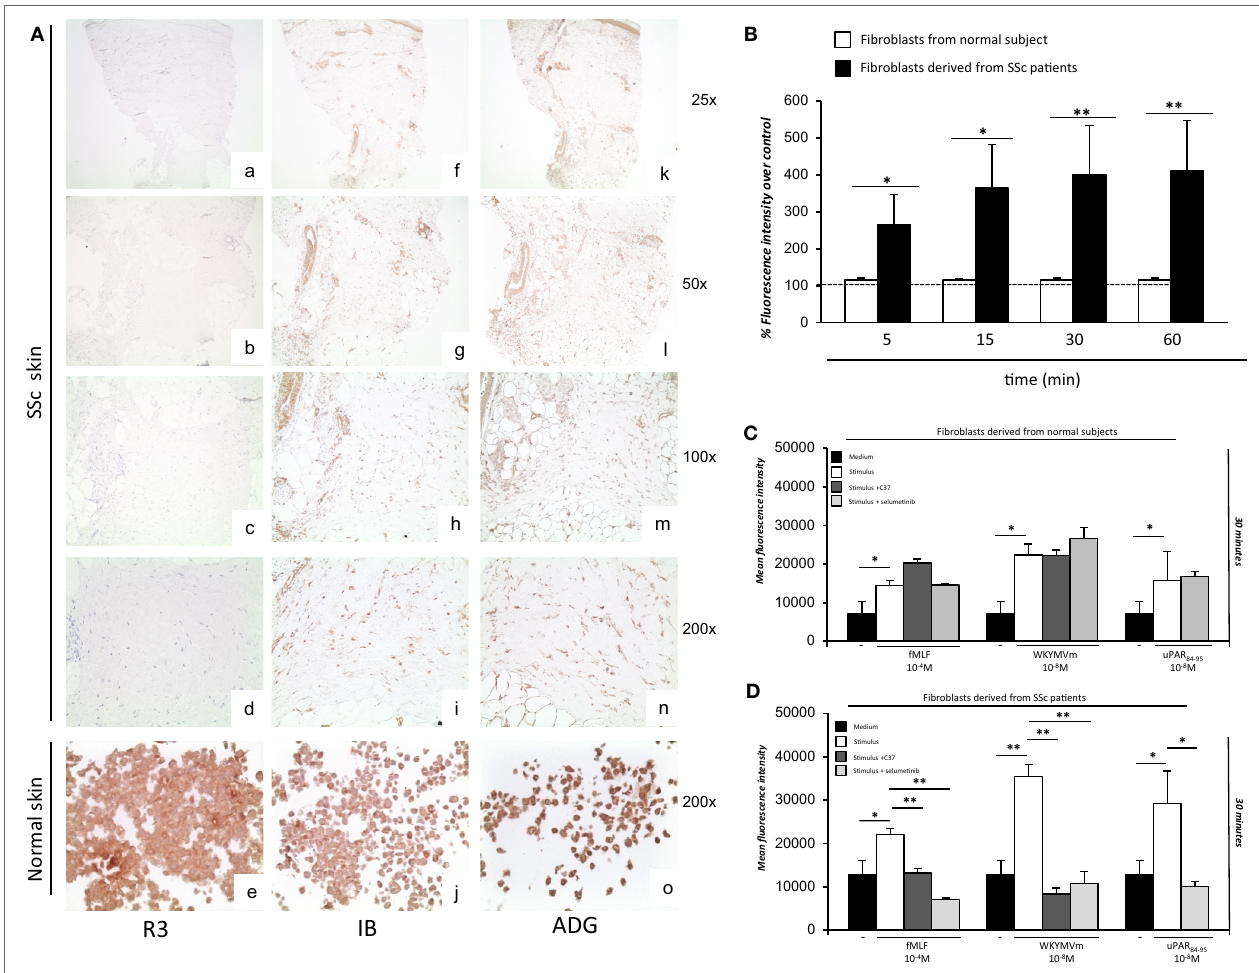
FigUre 7 | Ex vivo expression of uPAR forms and analysis of the effects of C37 and selumetinib on FPRs-mediated reactive oxygen species (ROS) production in fibroblasts derived from normal subjects and systemic sclerosis (SSc) patients. (a) (a–d) staining for R3 in localized scleroderma: fibroblasts, lymphocytes, and endothelial cells were negative for R3 (a: original magnification, × 25; b: original magnification, × 50, c: original magnification, × 100; d: original magnification, × 200); (e) staining for R3 in normal human fibroblast cell line: fibroblasts were positive for this antibody [original magnification, × 200] (f–i) staining for IB in localized scleroderma: most fibroblasts, lymphocytes and endothelial cells were positive for IB (f: original magnification, × 25; g: original magnification, × 50, h: original magnification, × 100; i: original magnification, × 200); (j) staining for IB in normal human fibroblast cell line: fibroblasts were positive for this antibody (original magnification, × 200) (k–n) staining for ADG3937 in localized scleroderma: positivity for ADG3937 was observed in fibroblasts, lymphocytes and endothelial cells (k: original magnification, × 25; l: original magnification, × 50, m: original magnification, × 100; n original magnification, × 200); (o) staining for ADG3937 in normal human fibroblast cell line: fibroblasts were positive for this antibody (original magnification, × 200) (B) Fibroblasts derived from normal subjects (white columns) and SSc patients (gray columns) were plated in a 96-well plate and treated with DCHF-DA. At the end of incubation, cells were washed, and ROS release was measured as dichlorofluorescein (DCF) fluorescence intensity. Results are expressed as a percentage of increase of mean fluorescence intensity of DCHF-DA–loaded cells, as compared with DCHF-DA–unloaded cells (considered as 100%). Values are the mean ± SEM of three experiments performed in triplicate. * p < 0.05; ** p < 0.001. (c) Fibroblasts derived from primary cultures of three normal subjects were plated in a 96-well plate and treated with DCHF-DA. At the end of incubation, cells were treated with fMLF, WKYMVm peptide, or uPAR 84–95 peptide in the absence (white columns) and in the presence of C37 (medium gray columns) or selumetinib (light gray columns). ROS release was measured as dichlorofluorescein (DCF) fluorescence intensity at 30 min. Values are the mean ± SEM of three experiments performed in triplicate. * p < 0.05. (D) Fibroblasts derived from primary cultures of three SSc patients were plated in a 96-well plate and treated with DCHF-DA. At the end of incubation, cells were treated with N -formyl- l -methionyl- l -leucyl- l -phenylalanine (fMLF), WKYMVm peptide, or uPAR 84–95 peptide in the absence (white columns) and in the presence of C37 (medium gray columns), selumetinib (light gray columns). ROS release was measured as DCF fluorescence intensity. Values are the mean ± SEM of three experiments performed in triplicate. * p < 0.05; ** p <